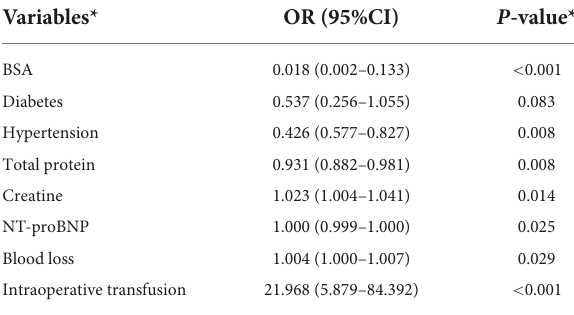
TABLE 2 Final logistic regression